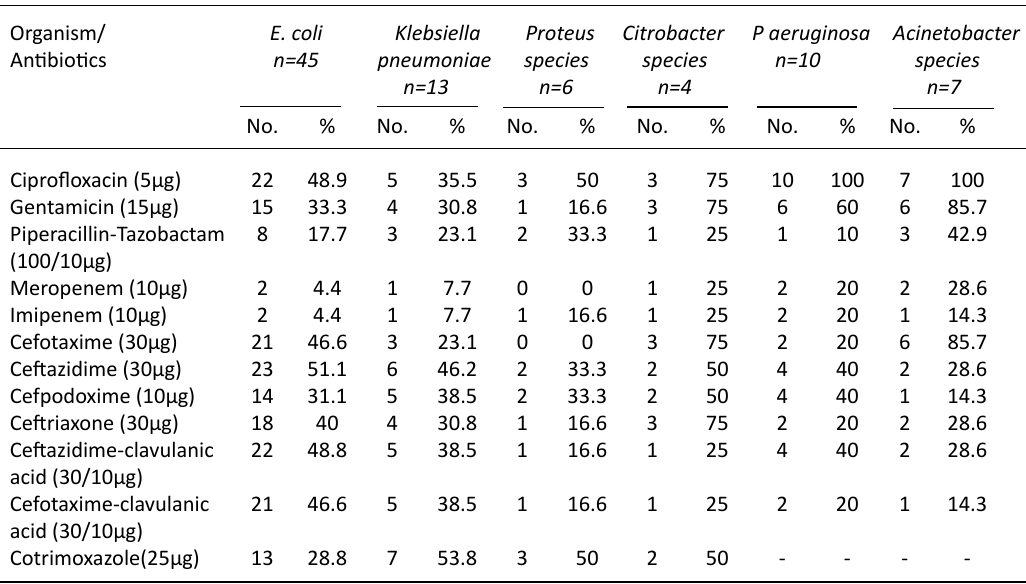
- - Detected by Detected